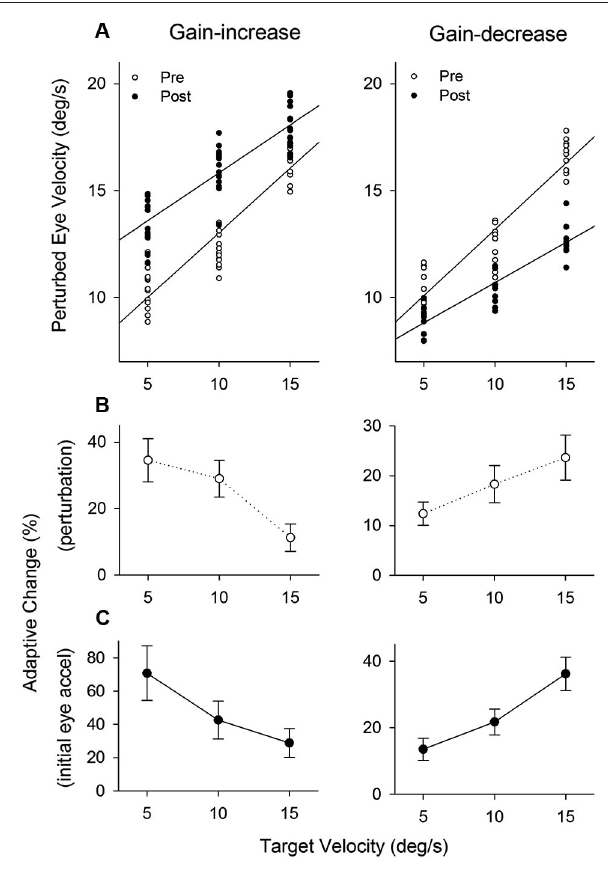
FIGURE 8 | The effect of pursuit adaptation on dynamic gain control . (A) Mean eye velocity of all the perturbation responses at three different target velocity conditions (5, 10 and 15 ◦ /s) for gain-increase (left) and decrease (right) experiments (top panels). Open and filled circles indicate pre- and post-adaptation, respectively. Straight lines are linear regression fits between perturbed eye velocity and target velocity. Two regression lines of pre- and post-adaptation have different slopes in gain-increase and decrease adaptation. (B–C) Percentages of adaptive change in the perturbation response and initial eye acceleration (first 100 ms of tracking) at three different target velocities for gain-increase and decrease